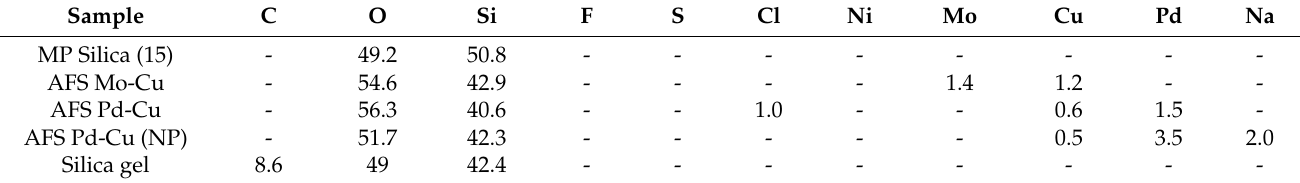
Table 1. Chemical composition of the analysed sorbents on the basis of EDS analysis,